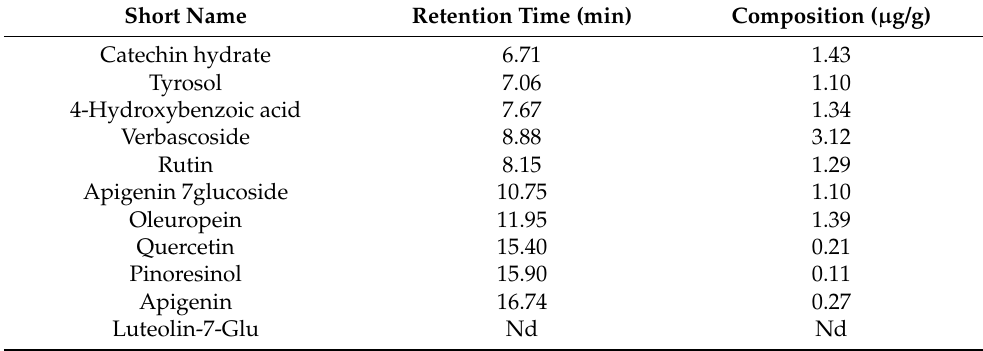
Table 2. Chemical composition of ethanol extracts from O. stricta cladode juice by HPLC analysis.